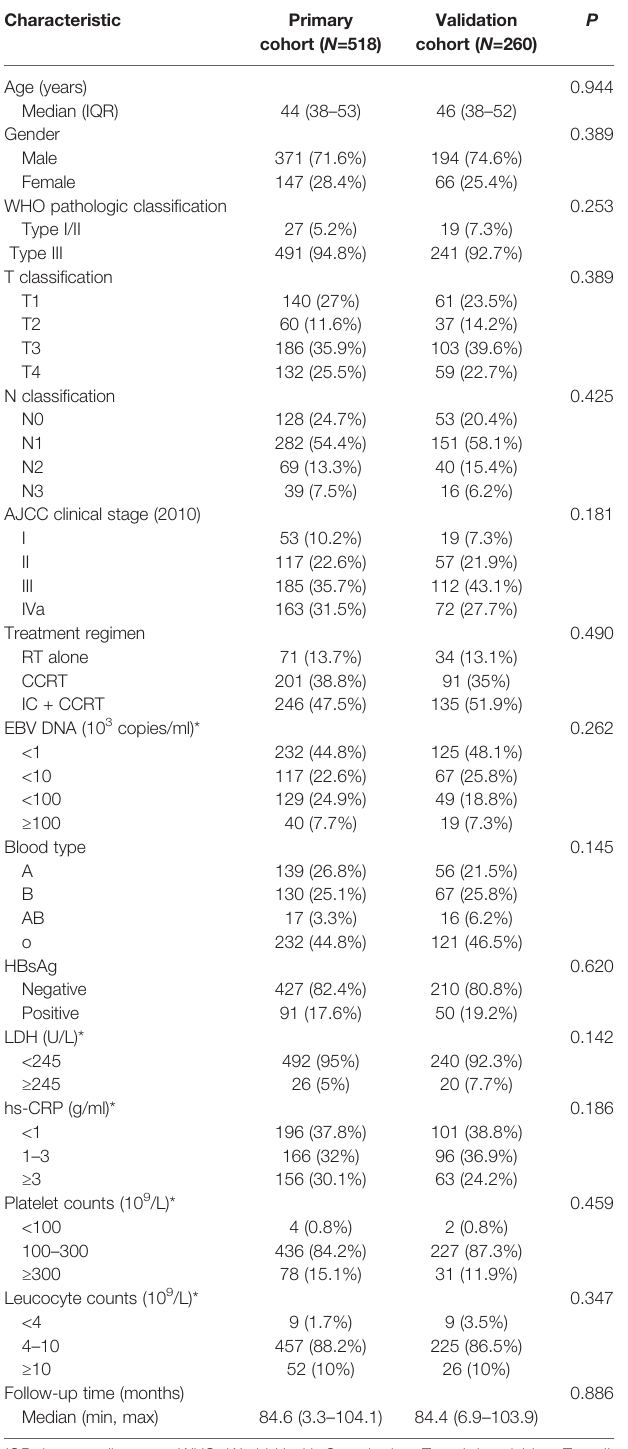
TABLE 1 | Patient demographic characteristics in the primary and validation cohorts.